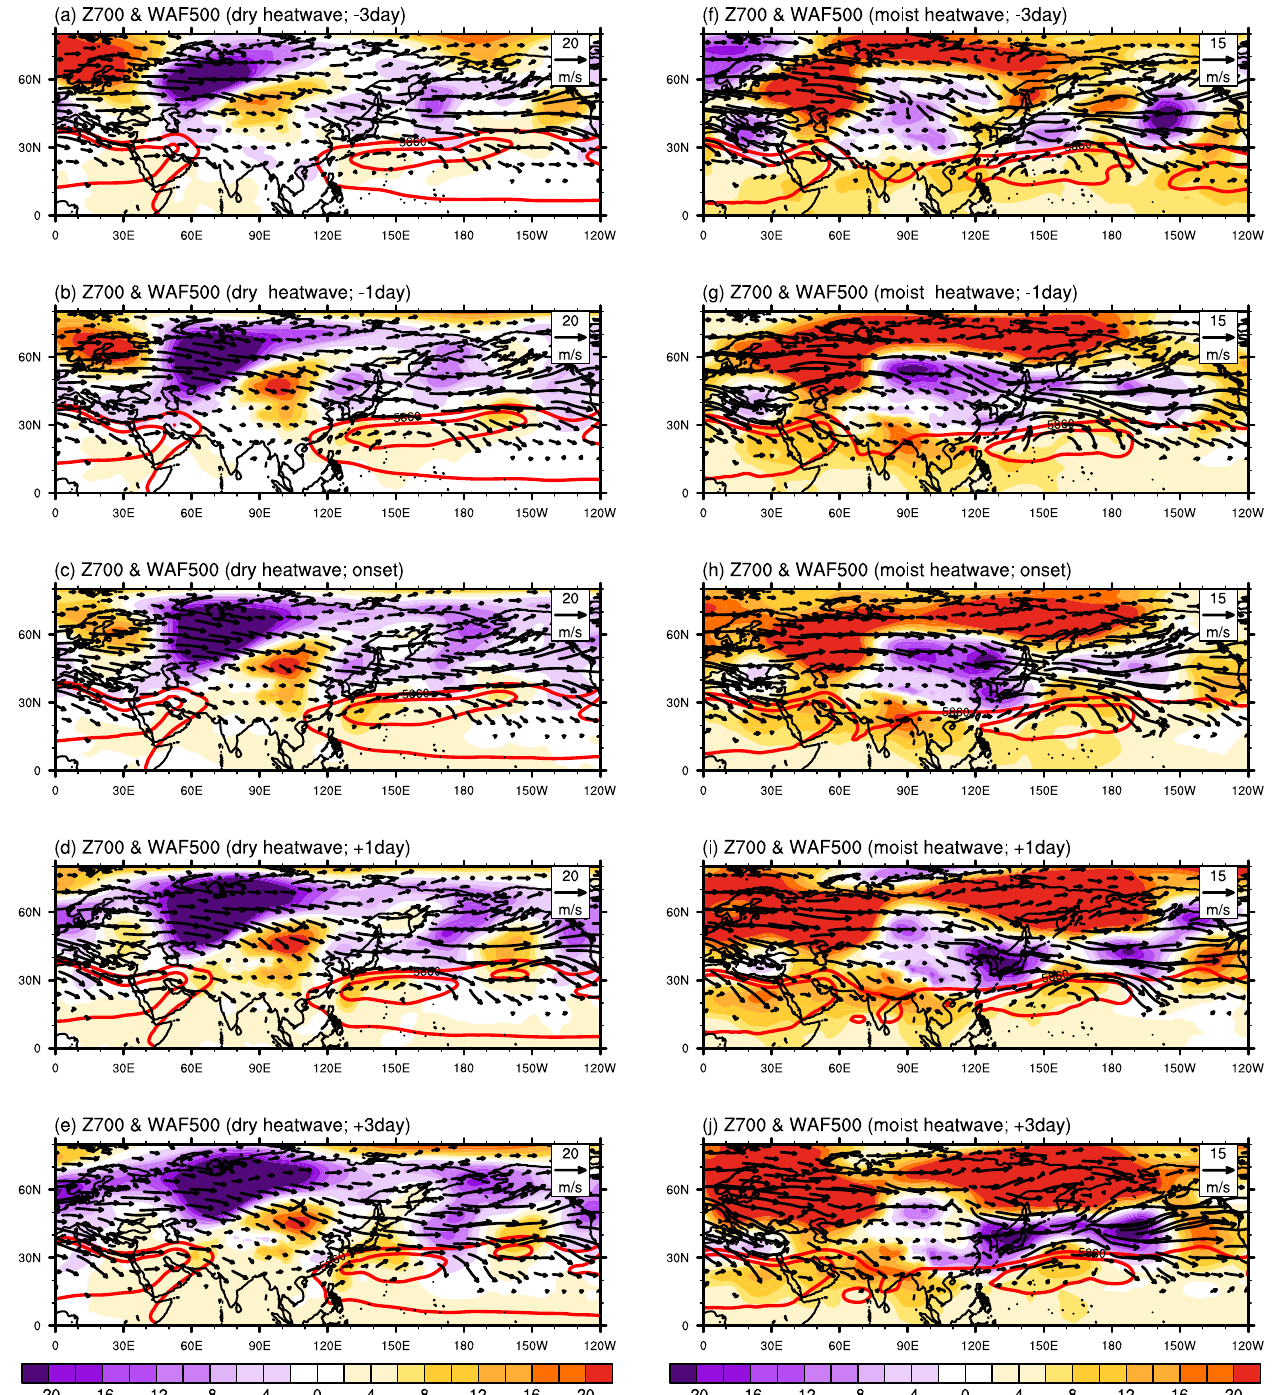
Fig. 3 Wave propagation from 3 days prior to onset up to 3 days after onset of heatwaves. Composite maps of geopotential height anomalies at 700 hPa (shading), geopotential height at 500 hPa (red contours), and wave activity fl ux (WAF) at 500 hPa (vectors) before and after the occurrence of a – e dry heatwaves and f – j moist heatwaves. To computed the WAF, the de fi nition proposed by Takaya and Nakamura (2001, JAS) was used. The normal state of the geopotential height is represented by the daily mean for the period 1958 – heatwave events. Hence, less cloud cover related to enhanced anticyclonic anomalies makes positive contributions to the surface warming over moist heatwave regions by increasing the insola- tion. The positive water vapor feedback associated with increased surface-to-atmosphere latent heat fl ux contributes to the warming of the surface, re fl ecting the moistening of air.